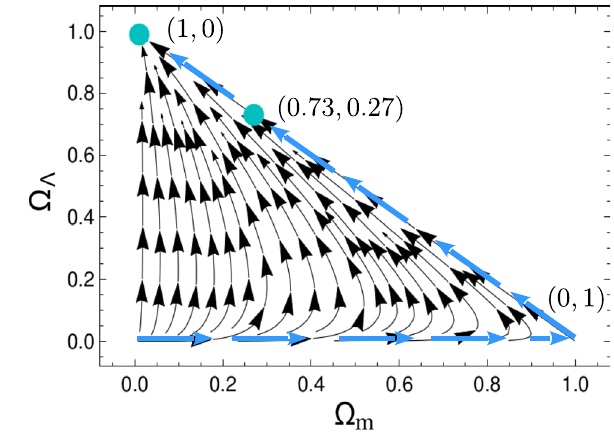
Fig. 2 Two-dimensional phase-space ((cid:6) m − (cid:6) (cid:2) ) for Model II and for ν (cid:2) = 0 . 01. Different trajectories correspond to different initial conditions. All of them meet at the attractor ∼ ( 0 . 0 , 1 . 0 ) at late times labelled with a point. Notice that our solution does not reach the de- Sitter solution, but it is undistinguishable from